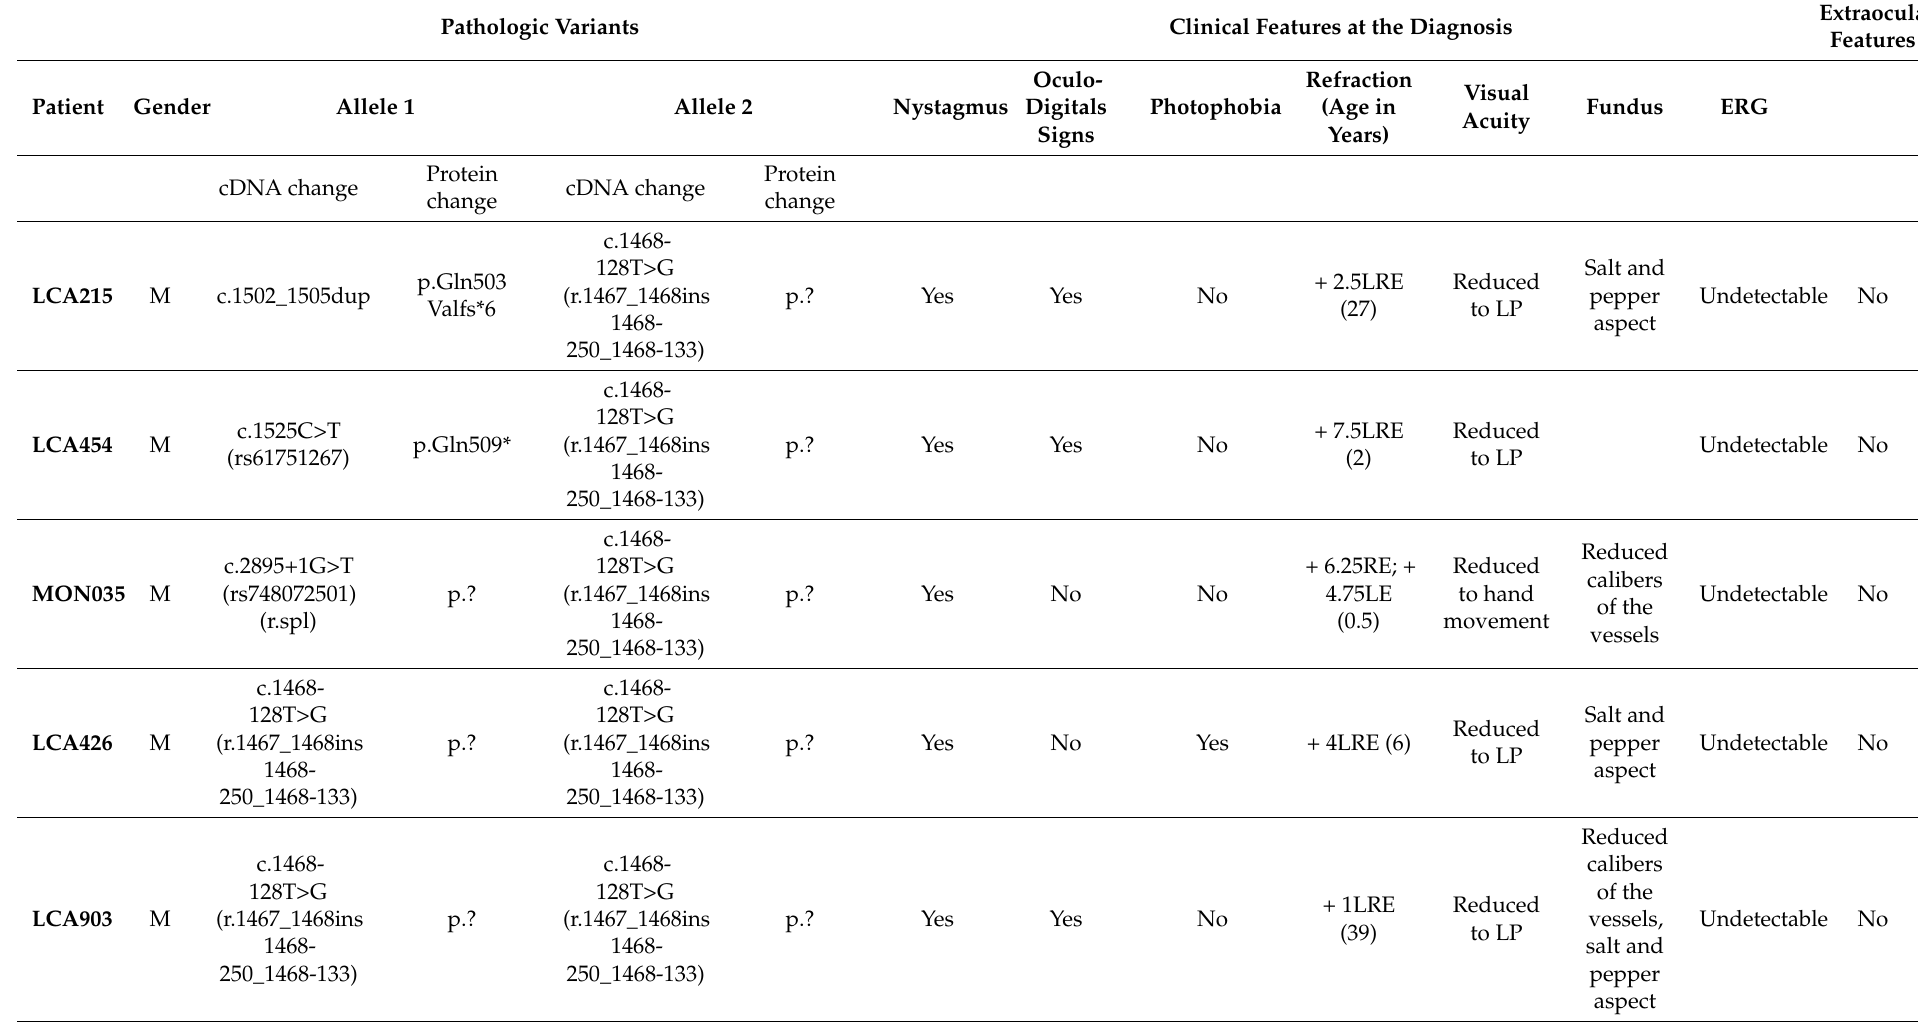
Table 1. RPGRIP1 variants and clinical characteristics of the patients with Leber congenital amaurosis (LCA) included in the present study. LP: light perception, RLE: right left eye, ERG: electroretinogram, na: not available.